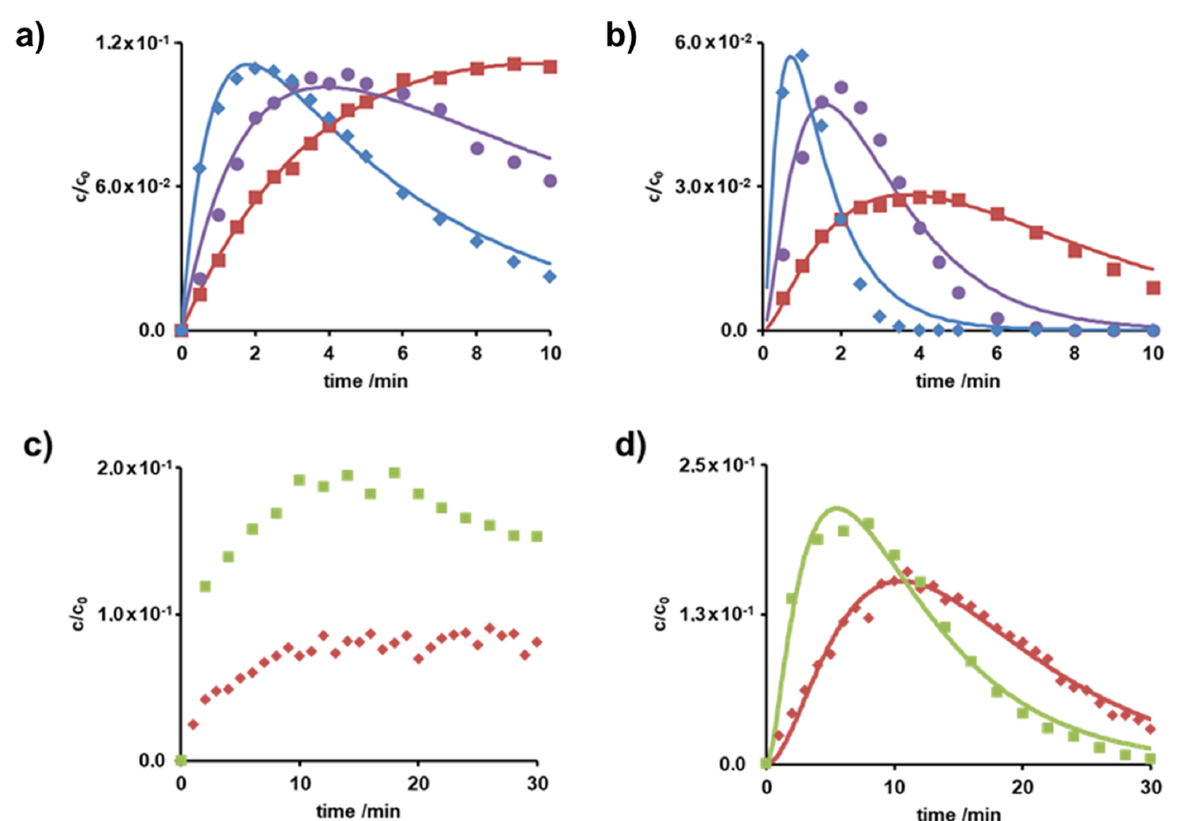
Figure 2. Normalized c-t -curves of photoinduced degradation products with ( a ) m/z = 134 and ( b ) m/z = 284 RT 4.1 min with 0 mg L − 1 H 2 O 2 (red, ■ ), with 10 mg L − 1 H 2 O 2 (violet, ● ) and 30 mg L − 1 H 2 O 2 (blue, ♦ ) and normalized c-t -curves of degradation or transformation products through ozonation with ( c ) m/z = 134 and ( d ) m/z = 300 RT 5.4 min using ozone flow (red, ♦ ) and in ozone-saturated solution (green, ■ ).